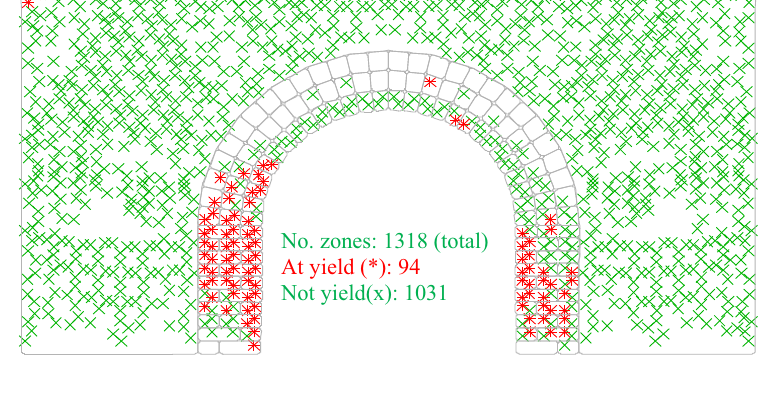
Fig. 8 Displacement vectors for UDEC C under concentrated load ( H =